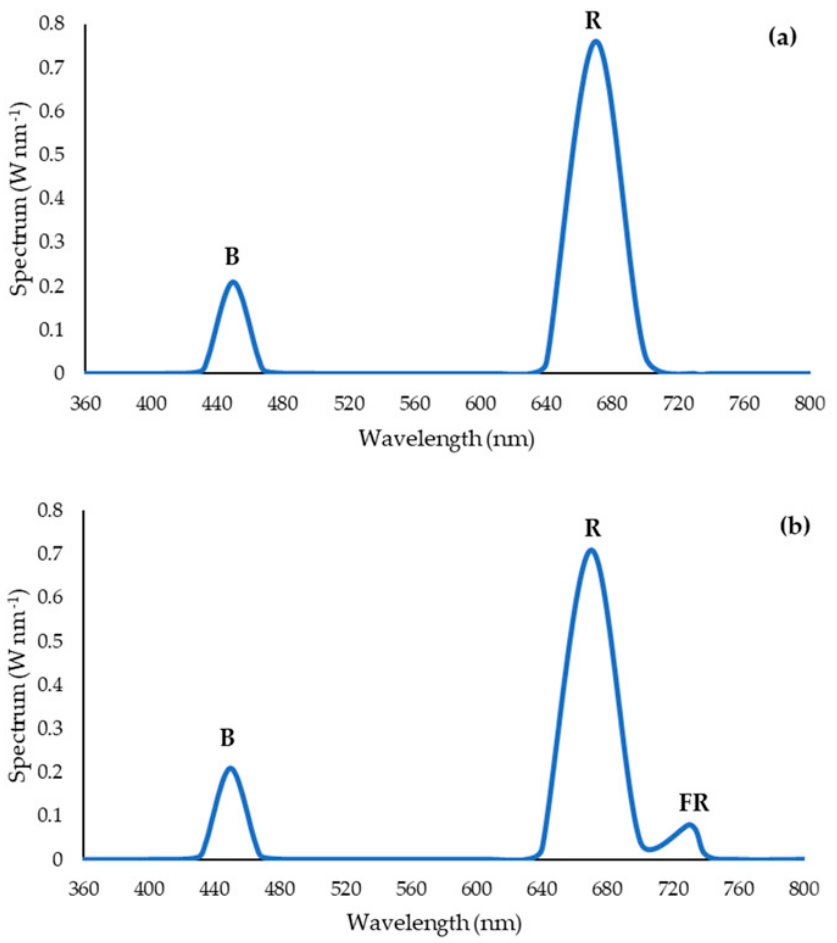
Figure 1. Light spectra of R + B LED interlight ( a ) and R + B + FR interlight ( b ), in W nm − 1 .